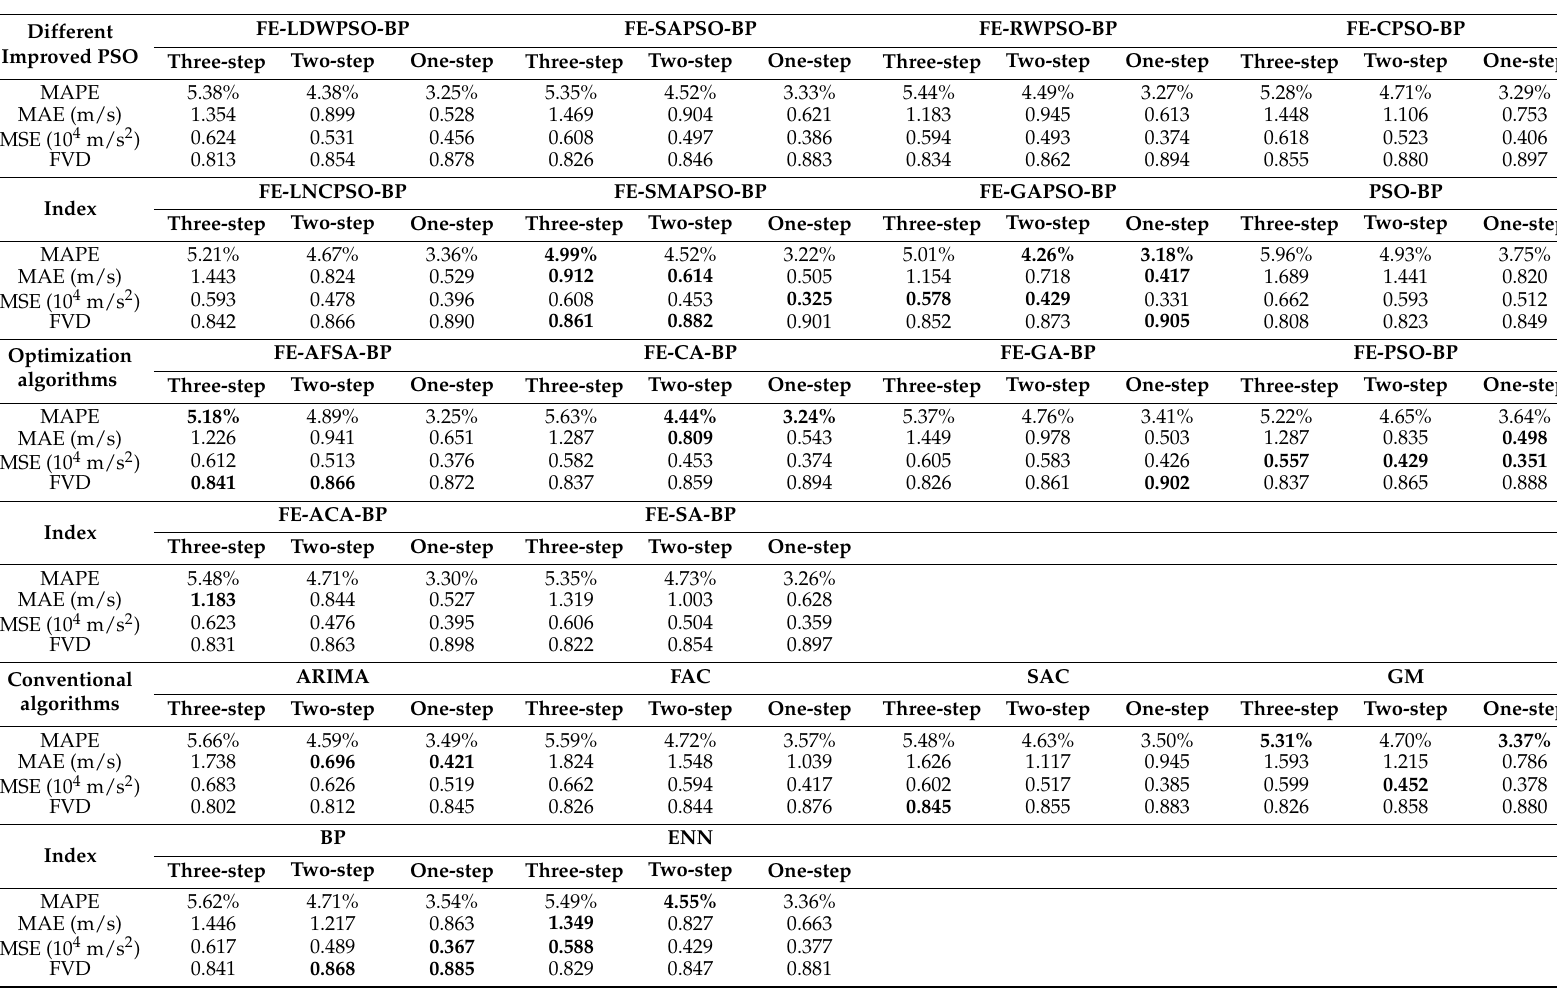
Table 4. Comparison of hybrid models with different optimization algorithms and conventional models for wind speed time